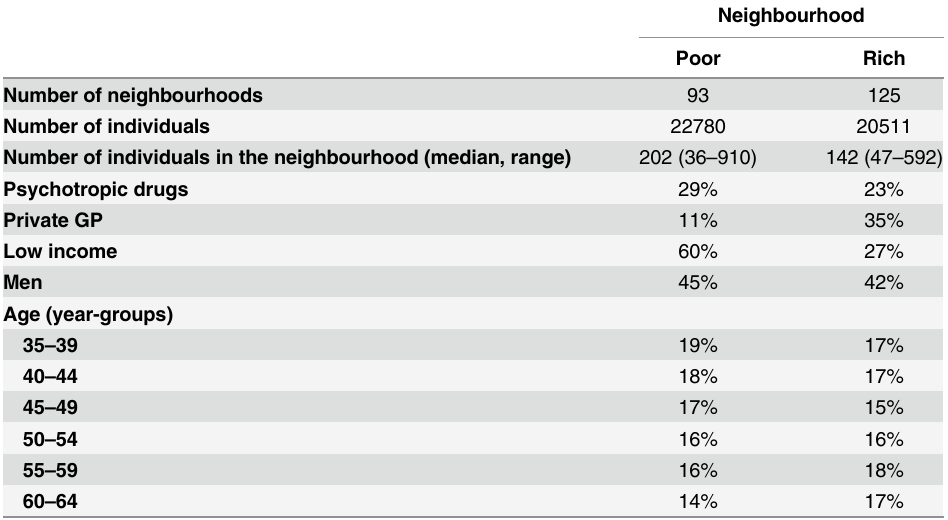
Table 1. Characteristics of the population 35 – 65 year-olds in Malmö, 2006 by neighbourhood